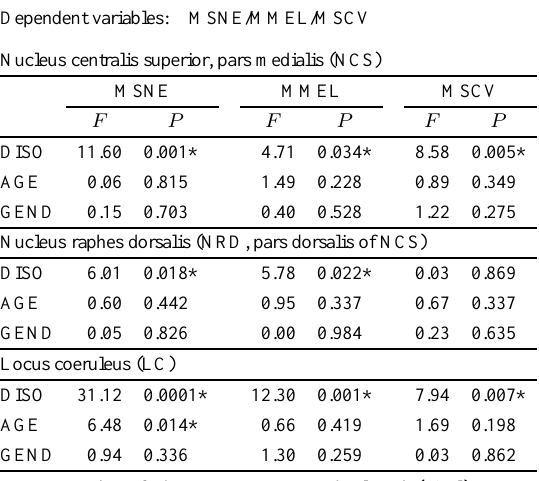
Percent change of means in disease groups as compared with the controls a,b Nucleus centralis superior, pars medialis (NCS)